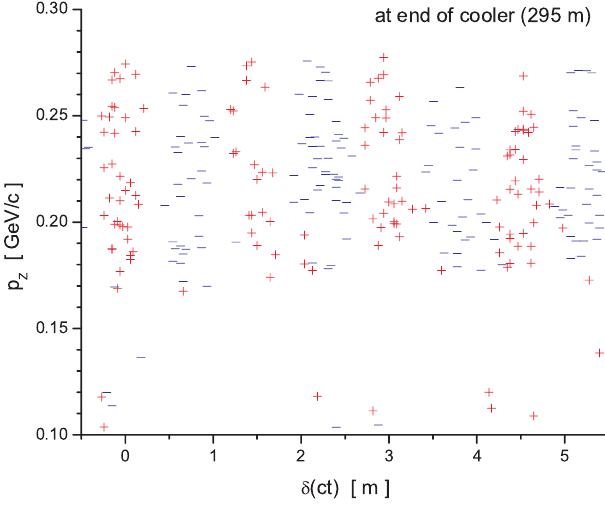
(cid:6) 30 mm rad and T (cid:6) 150 mm for a FIG. 18. (Color) A sample from the train of interleaved (cid:1) (cid:2) (red) L and (cid:1) (cid:1) (blue) bunches exiting the cooling section.